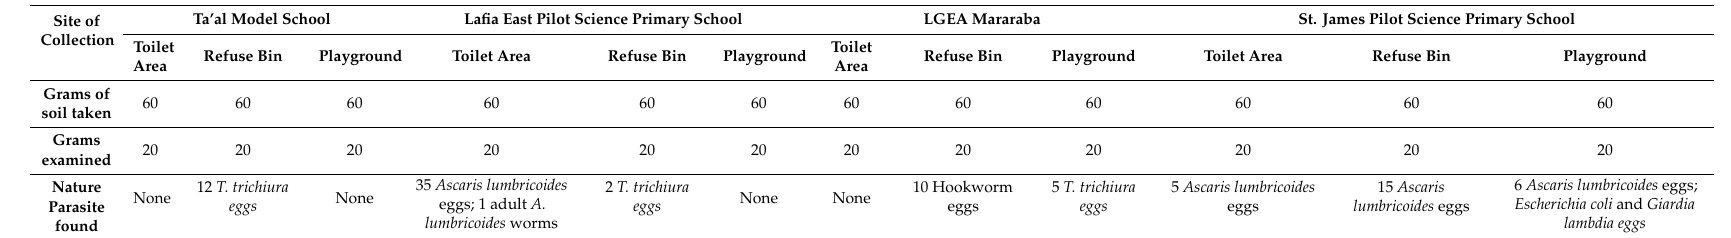
Table 3. Prevalence of soil-transmitted helminths found in soil samples of the four selected public schools.